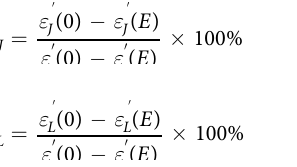
Table 2. The fitting parameters by using Eq. (4): anharmonic coefficient ( λ ), cluster size ( L ) and effective polarization ( P 0 ), the contribution of the Johnson term ( t J ) and Langevin term ( t L ), the overall tunability ( η ) of BTSn ceramics. * Parameters of BTSn11 are obtained based on the dielectric tunability data measured at 50 °C. Parameters of other samples are obtained based on the dielectric tunability data measured at 32